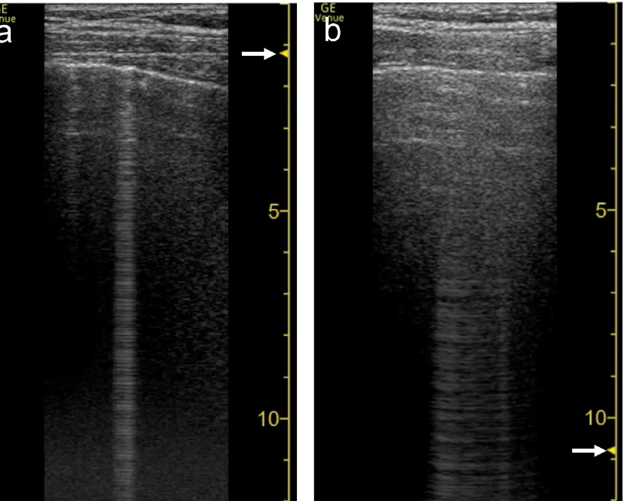
Figure 6. Ultrasound images obtained by Venue scanner (GE Healthcare) with a linear transducer. The B-line becomes wider as the single focal point (arrow) is shifted from the same level as the pleural line ( a ) to a deep level ( b ).